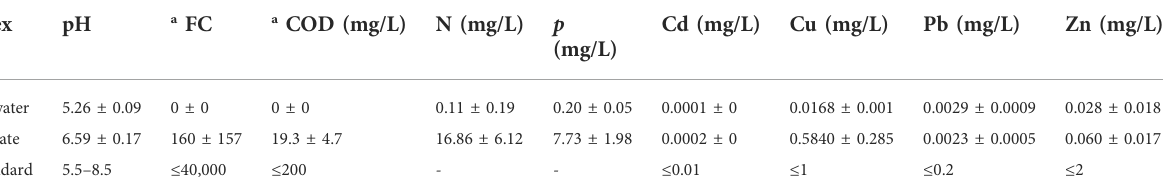
TABLE 5 Main properties of municipal sewage sludge leachate of the fi rst collections.